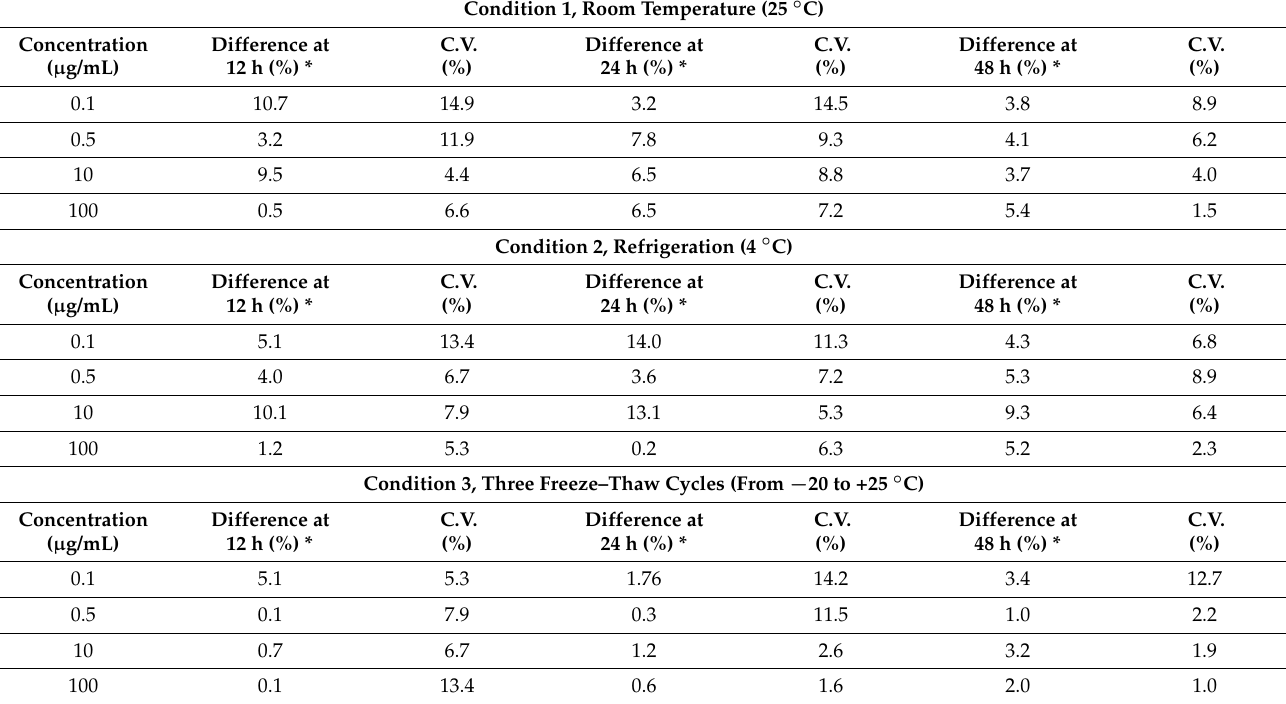
Table 3. The stability of C1 in rat plasma. Quality control samples of rat plasma were used at different concentrations (0.1, 0.5, 10, and 100 µ g/mL) in triplicate. The stability of C1 was evaluated under various conditions: condition 1, at room temperature (25 ◦ C) for 12, 24, and 48 h; condition 2, refrigeration (4 ◦ C) for 24, 48, and 72 h; condition 3, three freeze–thaw cycles (from − 20 to +25 ◦ C) for 24, 48, and 72 h.